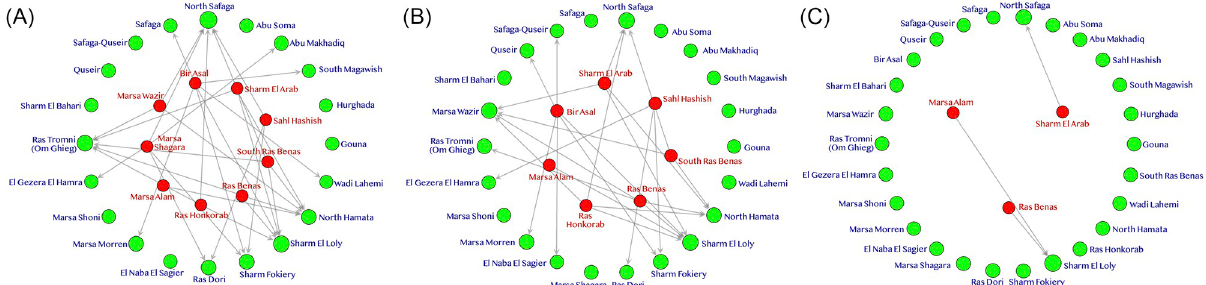
Fig 4. The reference plot for DEA-CCR, DEA-BCC, and FDH. A. The graphical results of the DEA-CCR model. B. The graphical results of the DEA-BCC model. C. The graphical results of the FDH model.